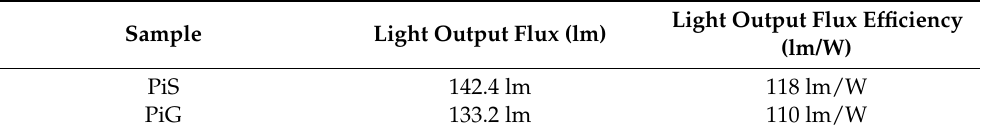
Table 2. Light output flux of PiS WLED and PiG WLED.